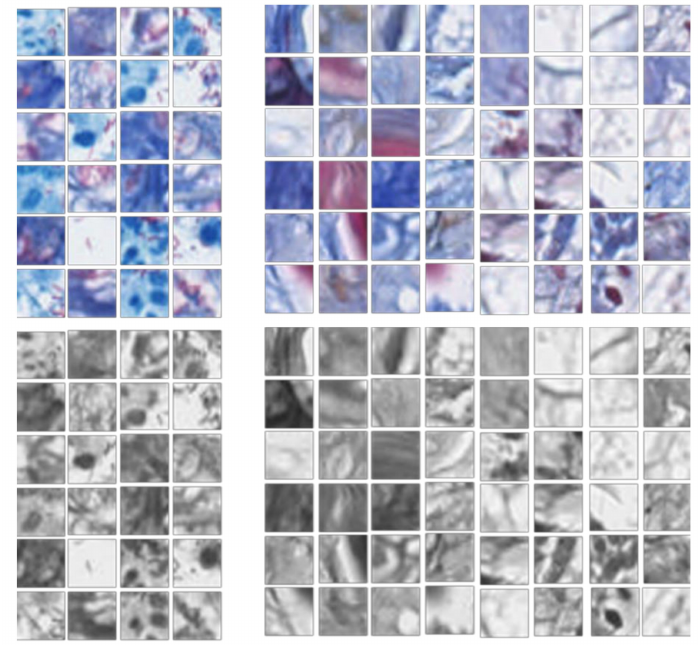
Figure 4. Color and grayscale training samples. The left group is positive blocks and the right group is negative